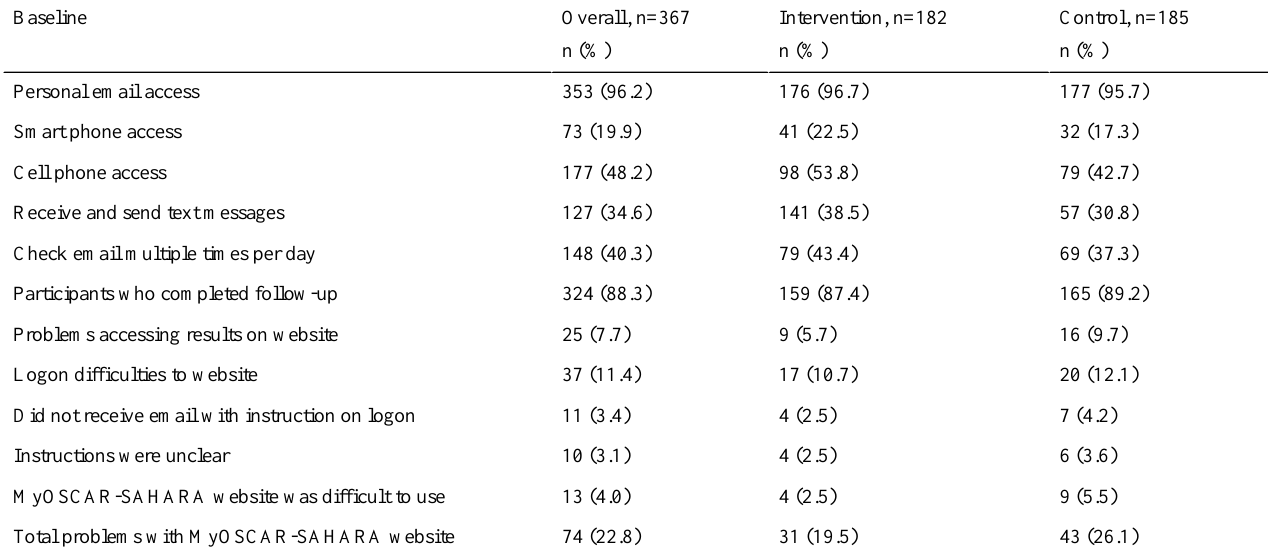
Table 3. Electronic access and reported technical